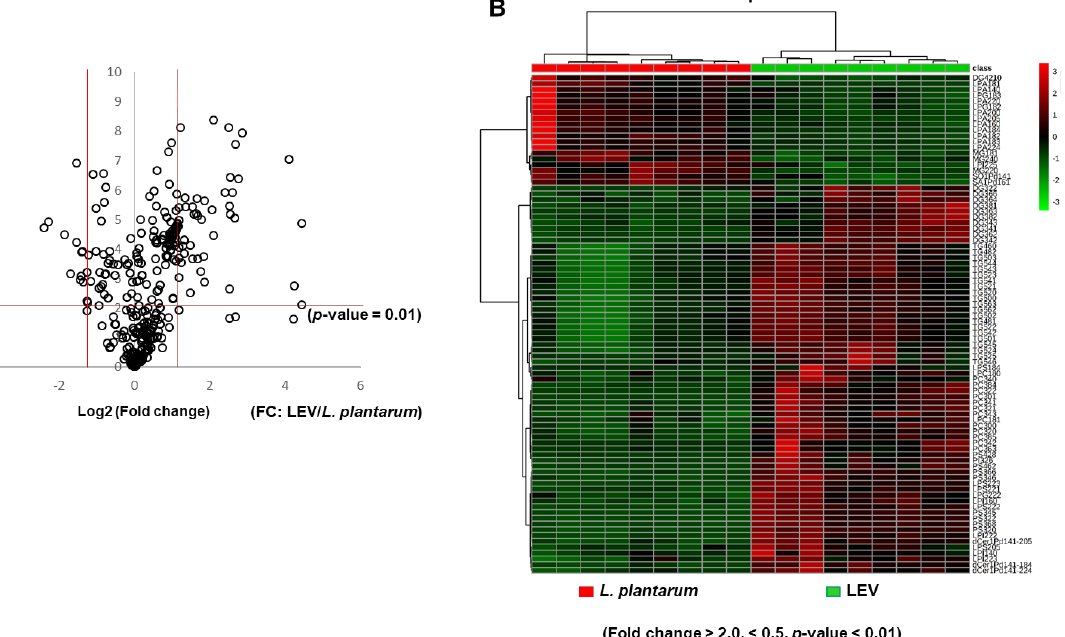
Figure 4. Di ff erentially enriched lipid species in LEVs versus L. plantarum . ( A ) The 320 identified lipids in LEVs are listed in a volcano plot according to their statistical p -value and fold changes compared to those in L. plantarum . Red lines at left and right sides represent distinct boundaries for fold-decreased ( < 0.5) or -increased ( > 2.0) lipid species, respectively, in LEVs compared to L. plantarum and the horizontal red line represents a boundary for the significance ( p < 0.01). Statistical significance was analyzed by Student’s t -tests for two groups. ( B ) Hierarchical clustering of di ff erentially enriched lipid species in LEVs versus L. plantarum (fold change > 2.0, < 0.5, p < 0.01). A heat map shows graphically the di ff erential fold changes of 86 lipid species in LEVs compared to L. plantarum . The relative fold di ff erence is encoded by color intensity. Red: increased; green: decreased.